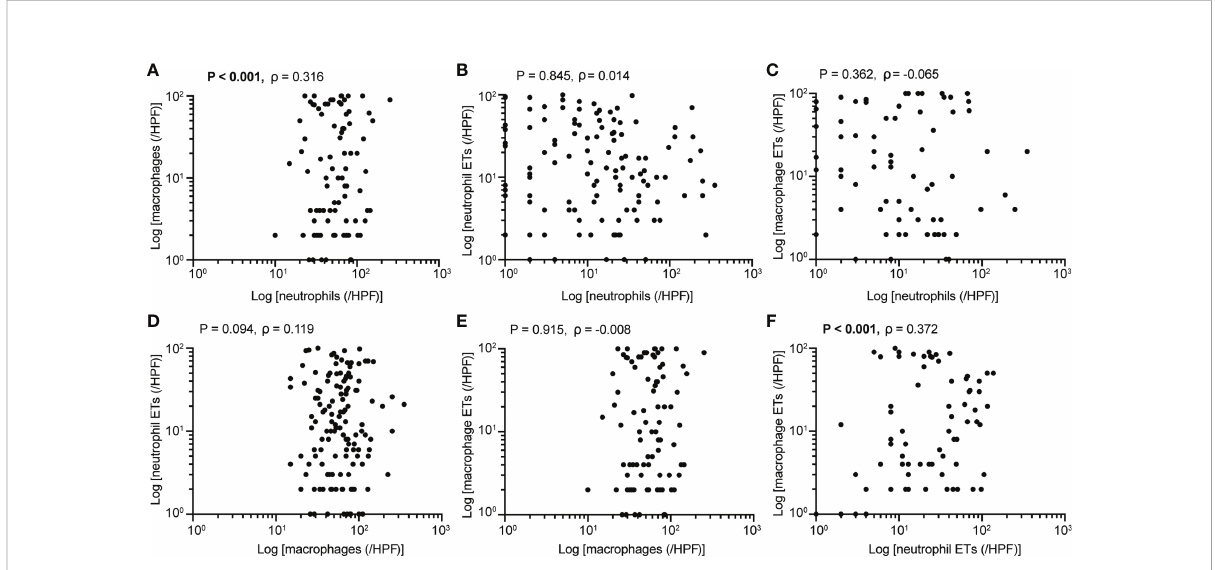
FIGURE 2 Associations between (A) neutrophil and macrophage in fi ltration (P<0.001), (B) neutrophil in fi ltration and ETs (P=0.845), (C) neutrophil in fi ltration and macrophage ETs (P=0.362), (D) macrophage in fi ltration and neutrophil ETs (P=0.094), (E) macrophage in fi ltration and ETs (P=0.915), (F) neutrophil and macrophage ETs (P<0.001) (Spearman ’ s correlation, n=205). P values <0.05 are